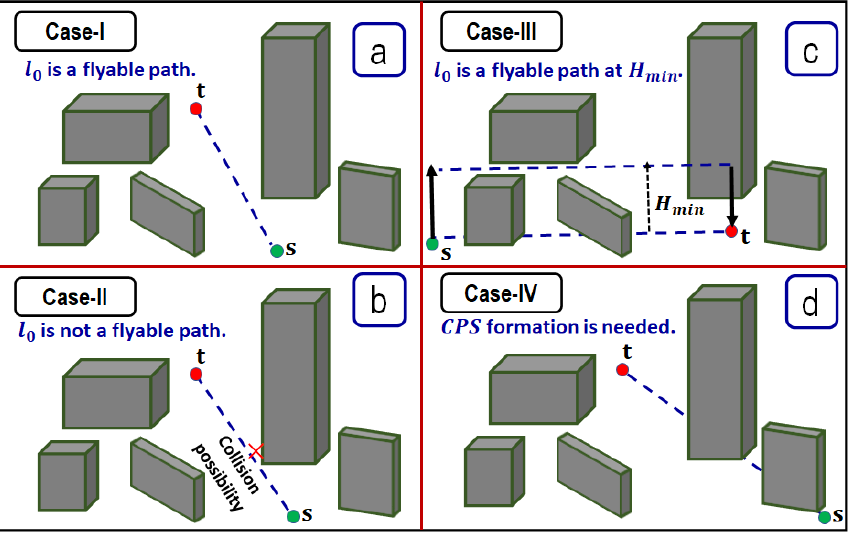
Figure 3. Results of sketching a straight line ( l o ) between s and t